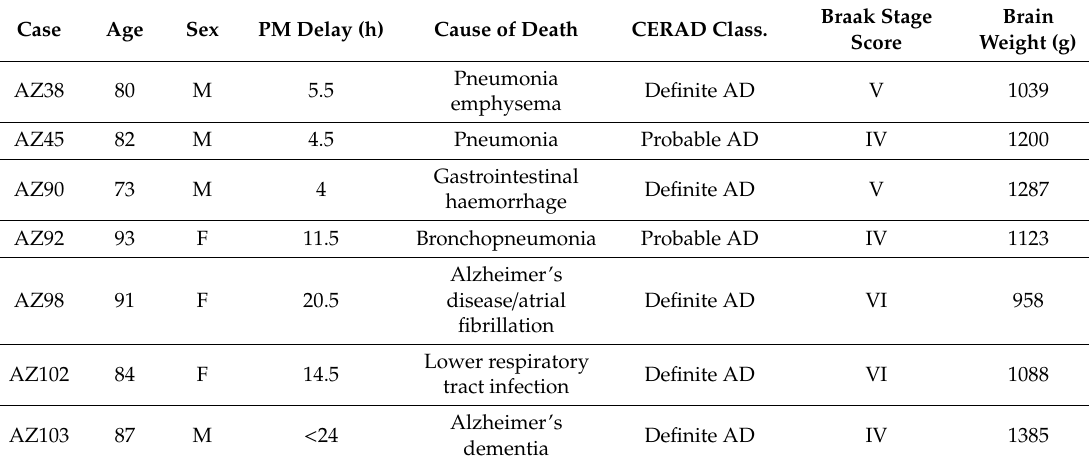
Table 4. Details of Alzheimer’s disease cases for fluorescence immunohistochemistry